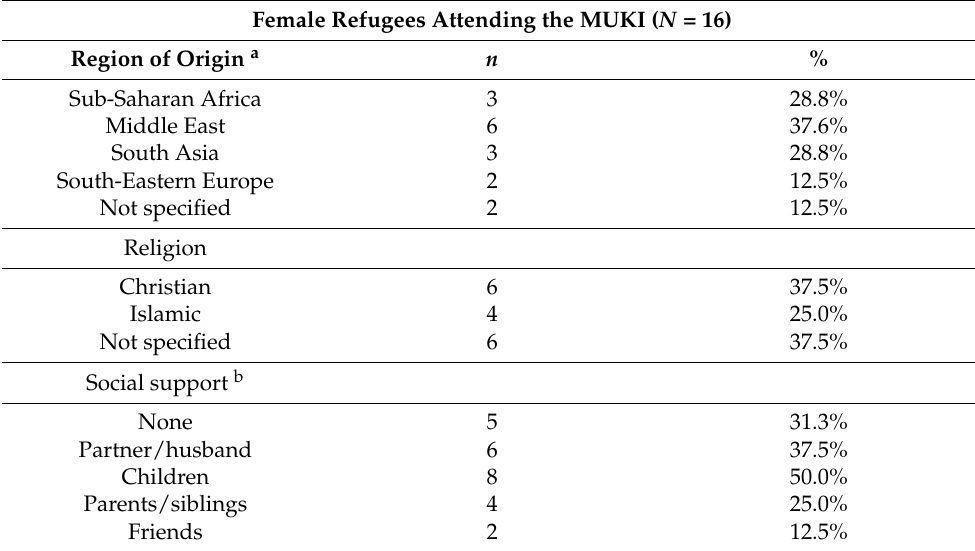
Table 1. Sample description of interviewed female refugees attending the MUKI ( N =